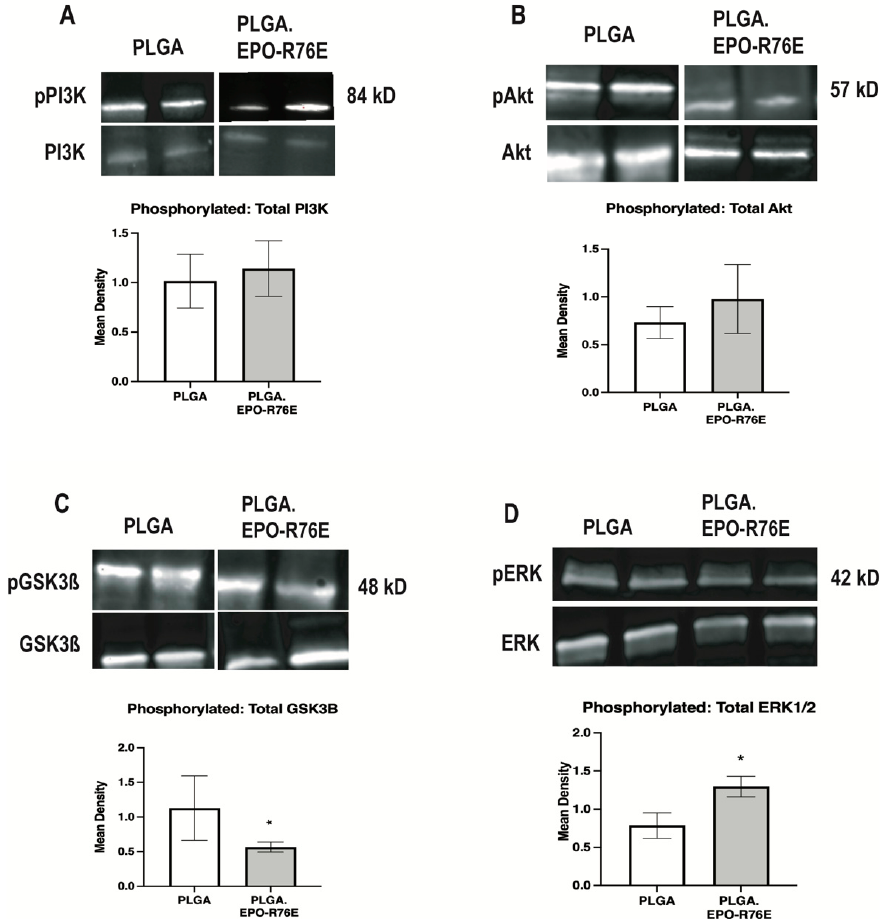
Figure 4. ( A ) Representative Western blot and quantification for pPI3K levels normalized to total PI3K levels. ( B ) Representative Western blot and quantification for pAkt levels normalized to total Akt levels. ( C ) Representative Western blot and quantification for pGSK3 β levels normalized to total GSK3 β levels. ( D ) Representative Western blot and quantification for pMAPK levels normalized to total MAPK levels, * p < 0.05.